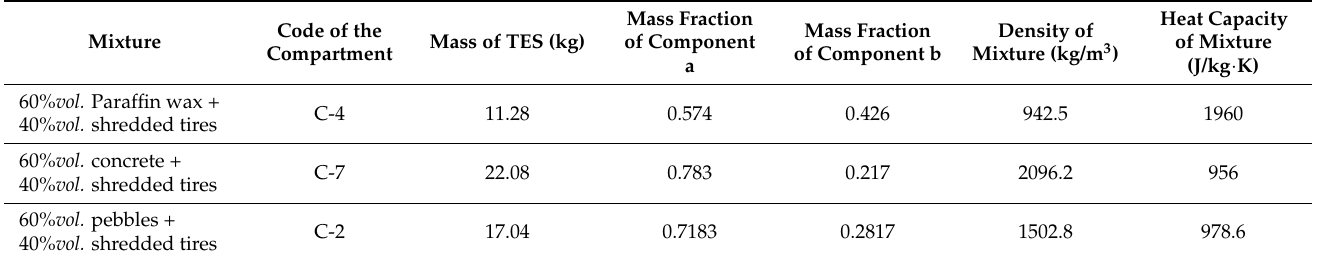
Table 4. Predicted density and heat capacity of mixtures.